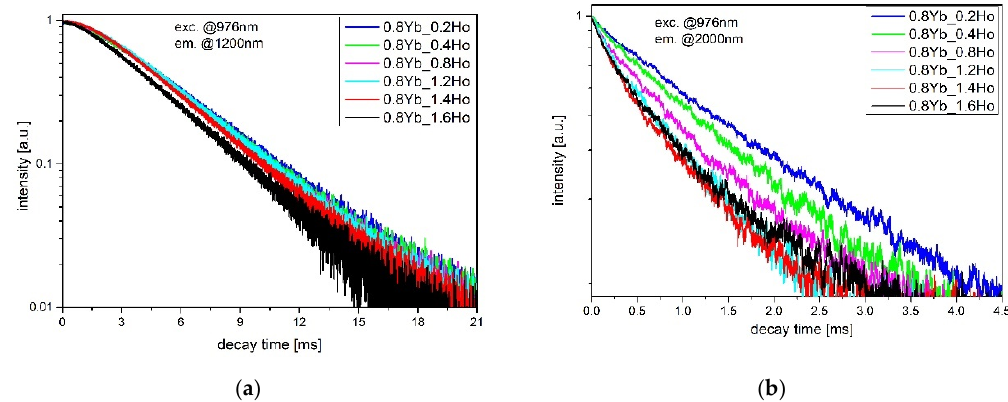
Figure 8. Luminescence decay curves from the Ho 3+ : 5 I 6 level ( a ) and 5 I 7 level ( b ) in Yb 3+ /Ho 3+ co-doped fluoroindate glasses, λ exc = 976 nm.